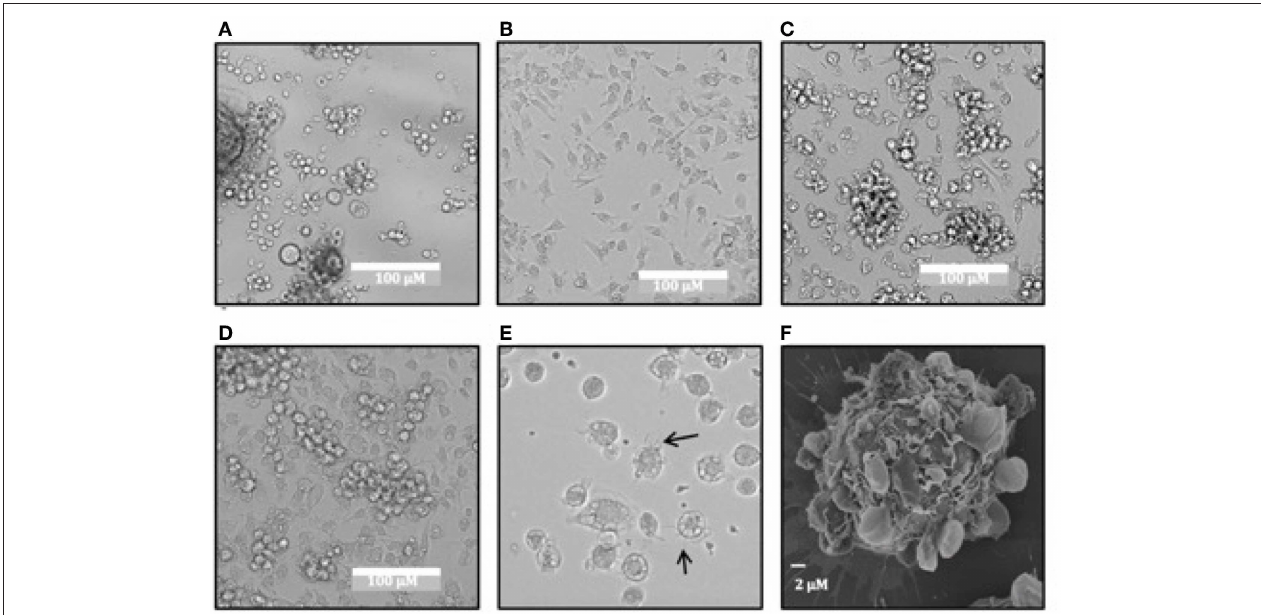
FIGURE 4 | Morphology of M. condylurus BMDCs. Dendritic cell morphology of bat bone-marrow cultures is shown on days 5 for cultures supplemented with mouse GM-CSF/IL4 (A) or equine GM-CSF/IL4 (B) and on days 7 (C) and 9 (D) and 10 (E) for cultures supplemented with equine GM-CSF/IL4. SEM images of DC cultures were taken on day 10 of culture at 5000x (F)